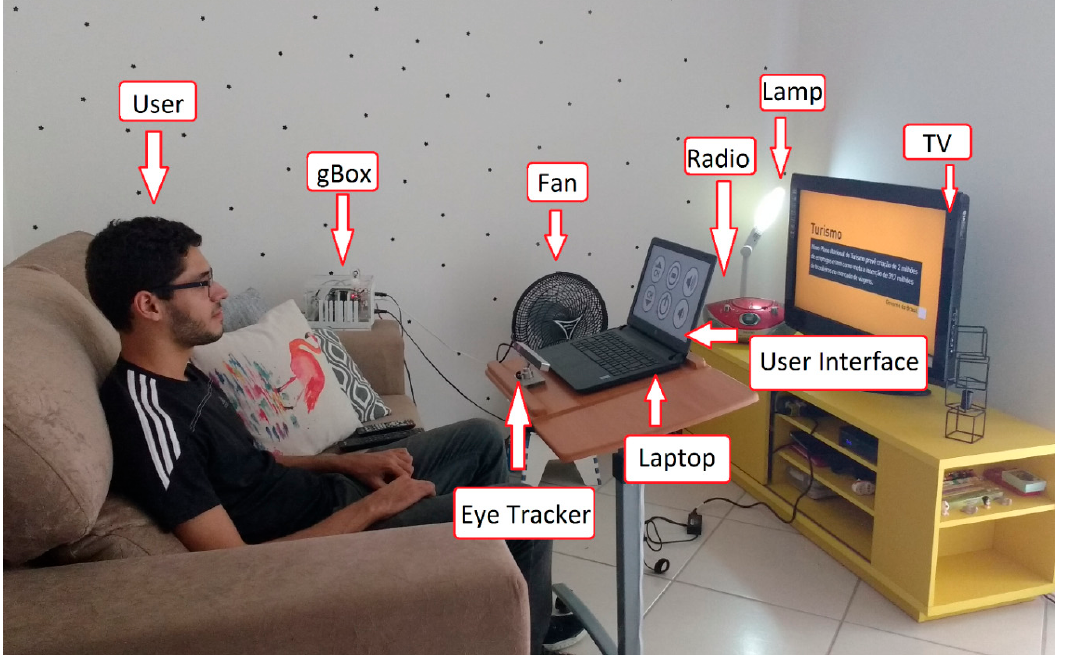
Figure 8. Able-bodied participant testing the system in the smart home.